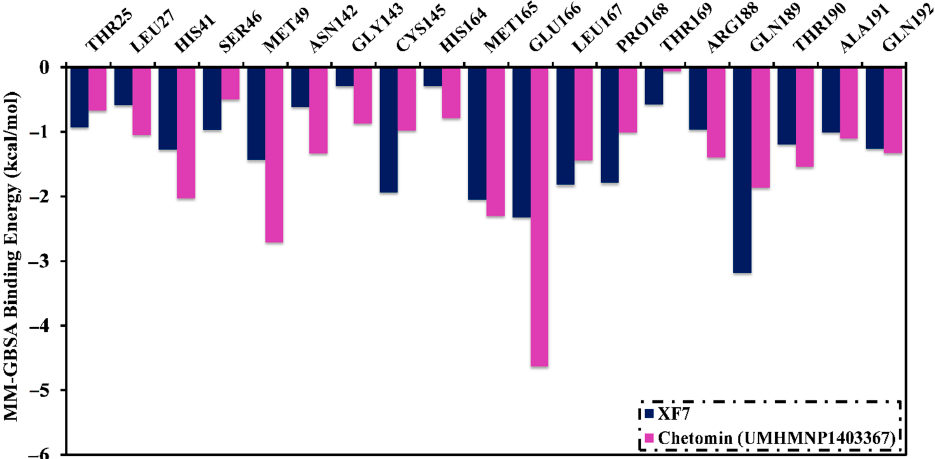
Figure 6. Per-residue decomposition of the binding affinity (kcal/mol) of chetomin (UMHMNP1403367) and XF7 complexed with 3CL pro over 200 ns MD simulations.